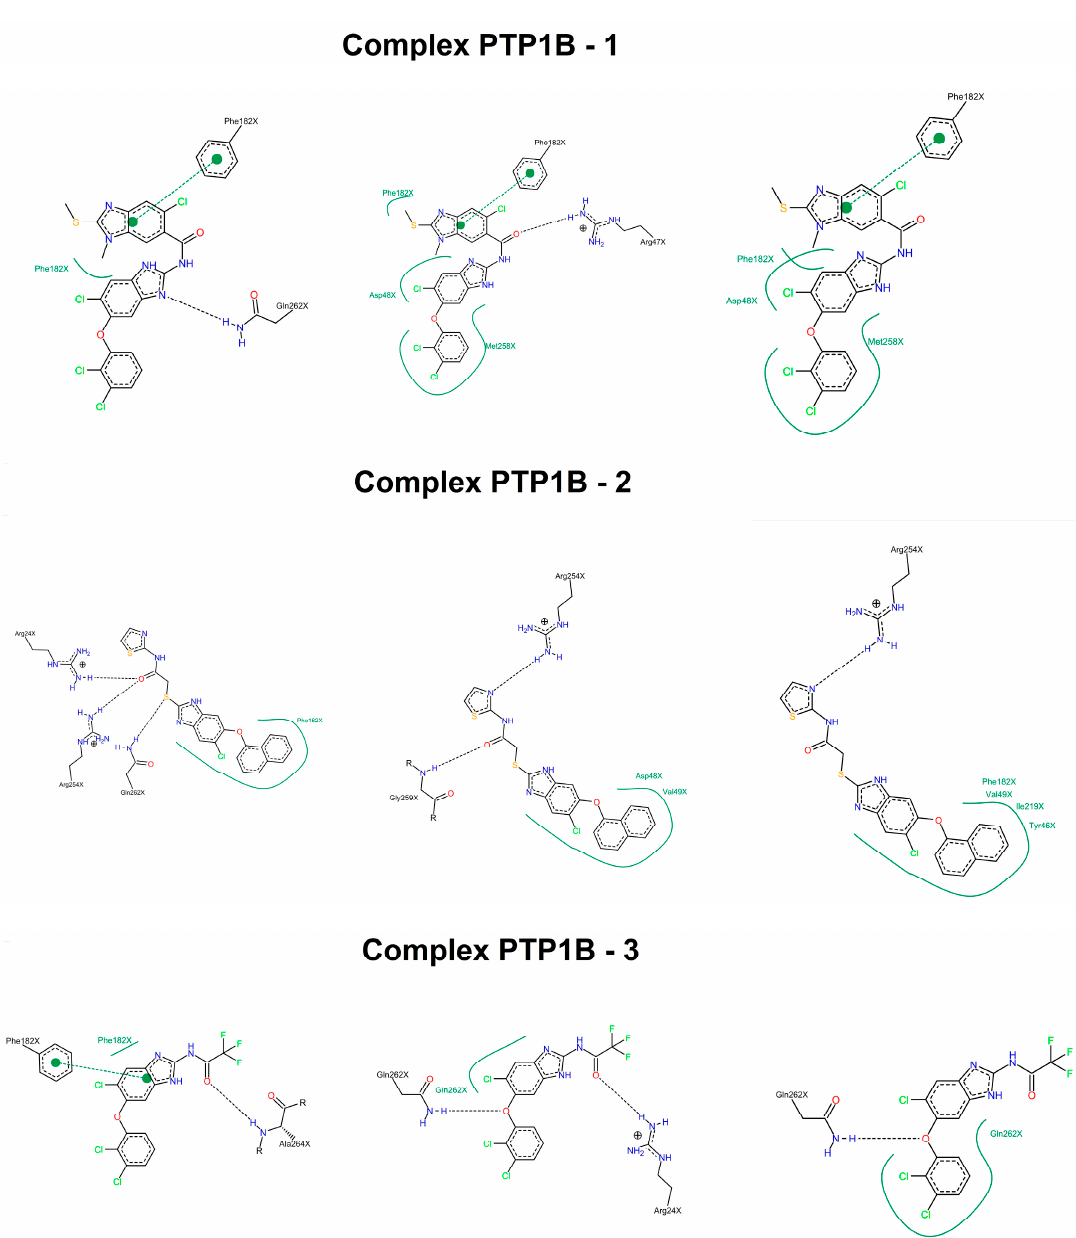
Figure 4. Two dimensional maps of interaction from the complexes PTP1B- 1 , PTP1B- 2, and PTP1B- 3 . The image shows interactions at different times during entire dynamics: beginning, stabilized (4 ns), and final (10 ns). Hydrogen bonds between protein and ligand are drawn as dashed lines. Hydrophobic contacts are represented by means of spline sections highlighting the hydrophobic parts of the ligand and the name of the contacting amino acid. Maps were generated in Server Poseview (http://proteinsplus.zbh.uni-hamburg.de/#poseview).